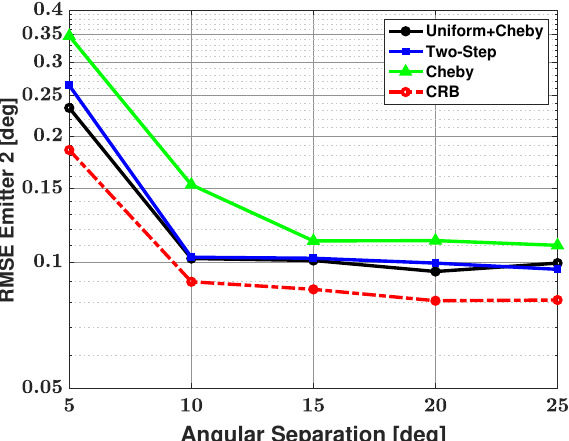
Figure 7. RMSE in the estimated direction of the second, weaker emitter versus angular separation between the two emitters: the three proposed methods are used for estimation, SNR of emitter #1 = 25 dB and emitter #2 = 0 dB, respectively; 100 snapshots, and 500 trials.